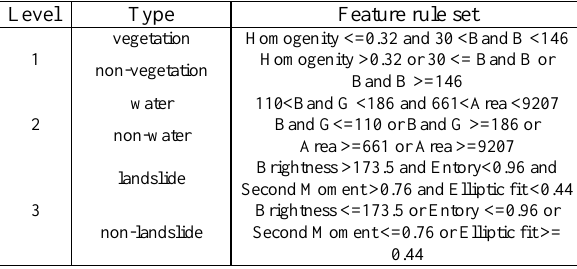
Table 1 Feature rule sets of different objects at different levels